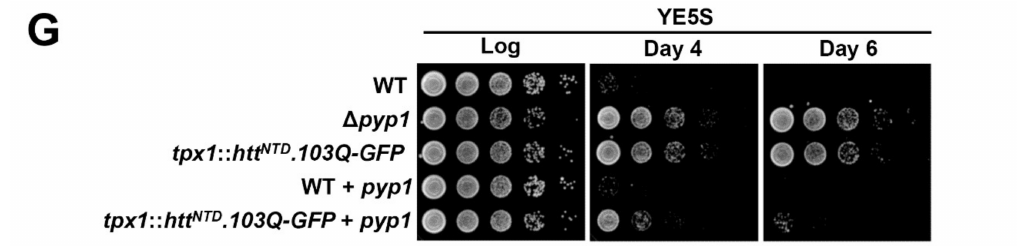
Figure 5. Expression of 103Q under the control of the constitutive tpx1 promoter promotes lifespan extension. ( A ) Wild-type (972), ∆ pyp1 (EP48) and strains expressing tpx1 -driven Htt NTD .nQ-GFP (AB1.4Q and AB1.103Q) were grown in YE5S for 3 days. Cultures from logarithmic (Log) or station- ary phase (Day 3) were serially diluted and spotted onto YE5S plates. ( B ) Wild-type (972), ∆ pyp1 (EP48), strains expressing tpx1 -driven Htt NTD .nQ-GFP (AB1.47Q and AB1.103Q), ∆ hsp104 (SG287) and ∆ hsp104 strains expressing tpx1 -driven Htt NTD .nQ-GFP (AB2.47Q and AB2.103Q) were grown in YE5S and treated as in ( A ). ( C ) Protein carbonyl (CO) determination of extracts from wild-type (972) and strains expressing tpx1 -driven Htt NTD .nQ-GFP (AB1.47Q and AB1.103Q) in logarithmic phase (Log) or in stationary phase (Day 4). Silver staining was used as loading control. ( D ) Wild-type (972), ∆ sty1 (AV18), ∆ pyp1 (EP48), strains expressing tpx1 -driven Htt NTD .nQ-GFP (AB1.47Q and AB1.103Q) and strains expressing tpx1 -driven TDP-43-YFP and TDP-43.M322K-YFP (LM210 and